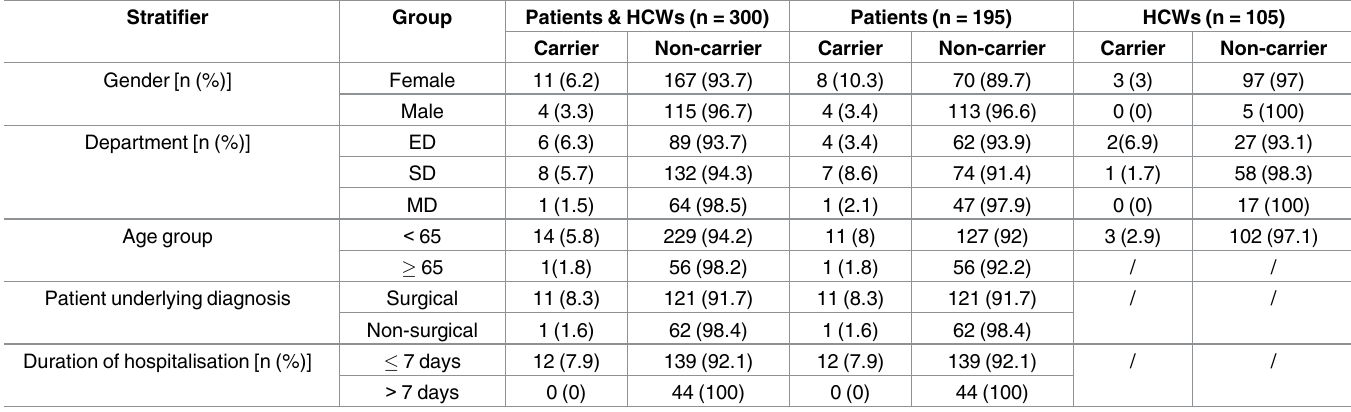
Table 1. Distribution of methicillin-resistant Staphylococcus sciuri (MRSS) carriersand non-carriers among patients and healthcare workers (HCWs) stratified by department, gender, age group, patient underlying diagnosis and duration of hospitalisation at the Clinical Centre of